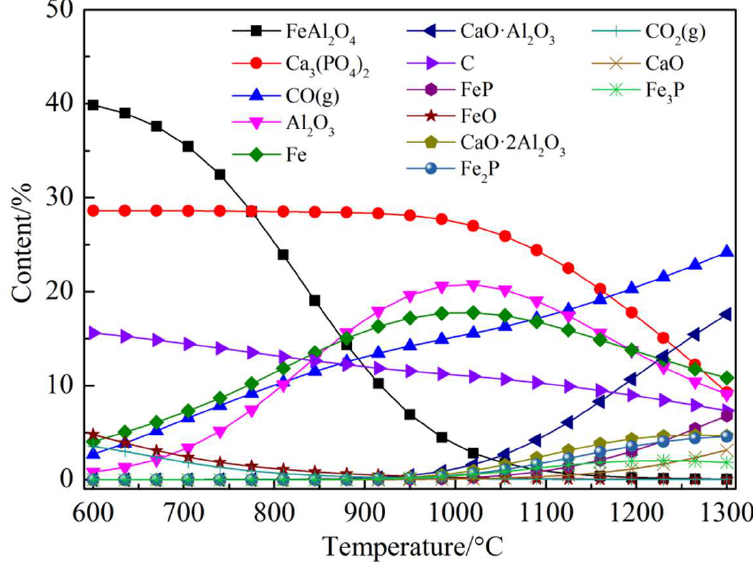
Figure 9. Thermodynamic equilibrium composition in the Ca 3 (PO 4 ) 2 –C–Fe 2 O 3 –Al 2 O 3 system.